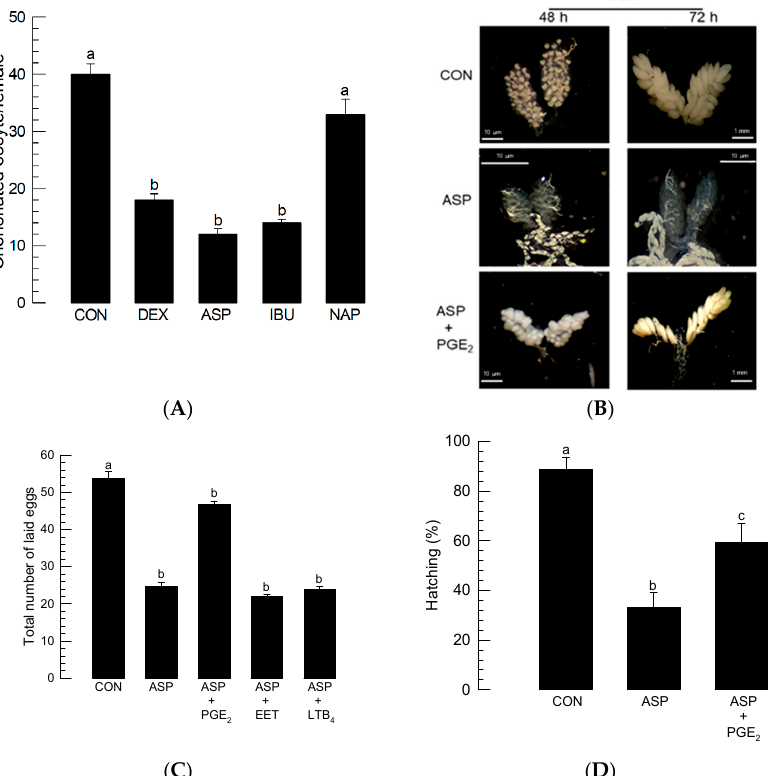
Figure 2. Effects of different eicosanoid biosynthesis inhibitors on the egg production of Ae. albopictus . PLA 2 inhibitor (dexamethasone: ‘DEX’), two COX inhibitors (ibuprofen: ‘IBU’, aspirin: ‘ASP’), and LOX inhibitor (naproxen: ‘NAP’) were used to treat 5-day-old females before blood-feeding (‘BF’). At 10 min before BF, the inhibitor was injected into females at a dose of 1 μ g/individual. Dimethyl sulfoxide (‘DMSO’, 10%) used to dissolve inhibitors was injected as a control (‘CON’). ( A ) Effect of inhibitors on the number of chorionated oocytes at 72 h after BF (‘PBF’). Each treatment was assessed using 10 females. ( B ) Rescue effect of PGE 2 (100 ng/adult) on choriogenesis of females treated with ASP (100 ng/adult). Ovaries were observed at 48 h and 72 h PBF. ( C ) Rescue effect of PGE 2 on choriogenesis of ASP-treated females. ASP was injected at a dose of 1 µg/individual. PGE 2 , 14,15-EET, or LTB4 was injected into ASP-treated females at a dose of 100 ng/adult. After BF, three females were allowed to mate with one male in each replication. Each treatment was replicated three times. The number of laid eggs was counted for 6 days PBF. ( D ) Decrease in the hatching rate of eggs laid by the ASP (1 µ g/individual)-treated females. To capture the rescue effect, PGE 2 (100 ng/adult) was injected along with ASP. Each replication used 100 eggs. Each treatment was replicated three times. The different letters above the standard error bars indicate significant differences among means at Type I error = 0.05 (LSD